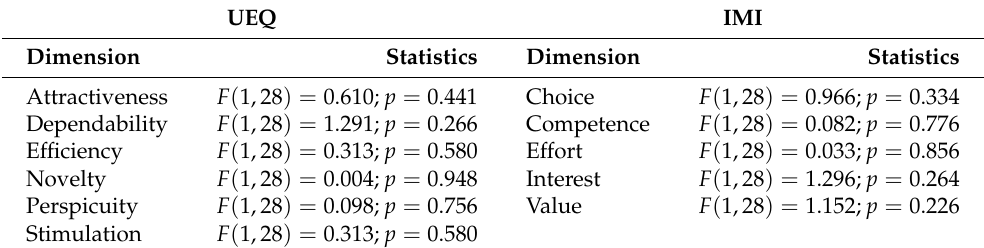
Table 1. Results from the between-subject ANOVA for UEQ and IMI. UEQ IMI Dimension Statistics Dimension Statistics Attractiveness F ( 1,28 ) = 0.610; p = 0.441 Choice F ( 1,28 ) = 0.966; p = 0.334 Dependability F ( 1,28 ) = 1.291; p = 0.266 Competence F ( 1,28 ) = 0.082; p = 0.776 Efficiency F ( 1,28 ) = 0.313; p = 0.580 Effort F ( 1,28 ) = 0.033; p = 0.856 Novelty F ( 1,28 ) = 0.004; p = 0.948 Interest F ( 1,28 ) = 1.296; p = 0.264 Perspicuity F ( 1,28 ) = 0.098; p = 0.756 Value F ( 1,28 ) = 1.152; p = 0.226